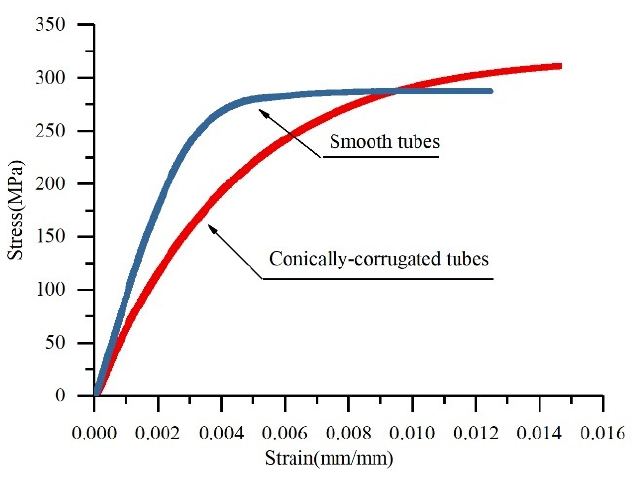
Figure 3. Comparison of experimental stress–strain curves of the conically corrugated tubes and smooth tubes ( D = 25 mm, t = 2.5 mm).